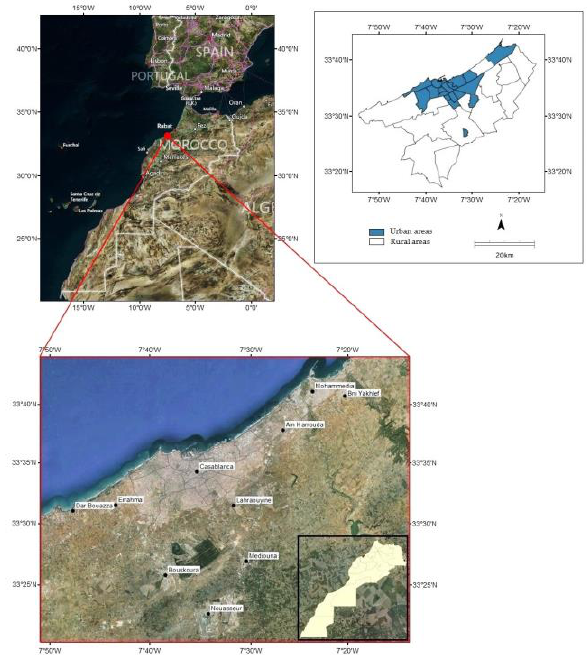
Figure 1 . Location of the study area. (Bahi et al., 2016).